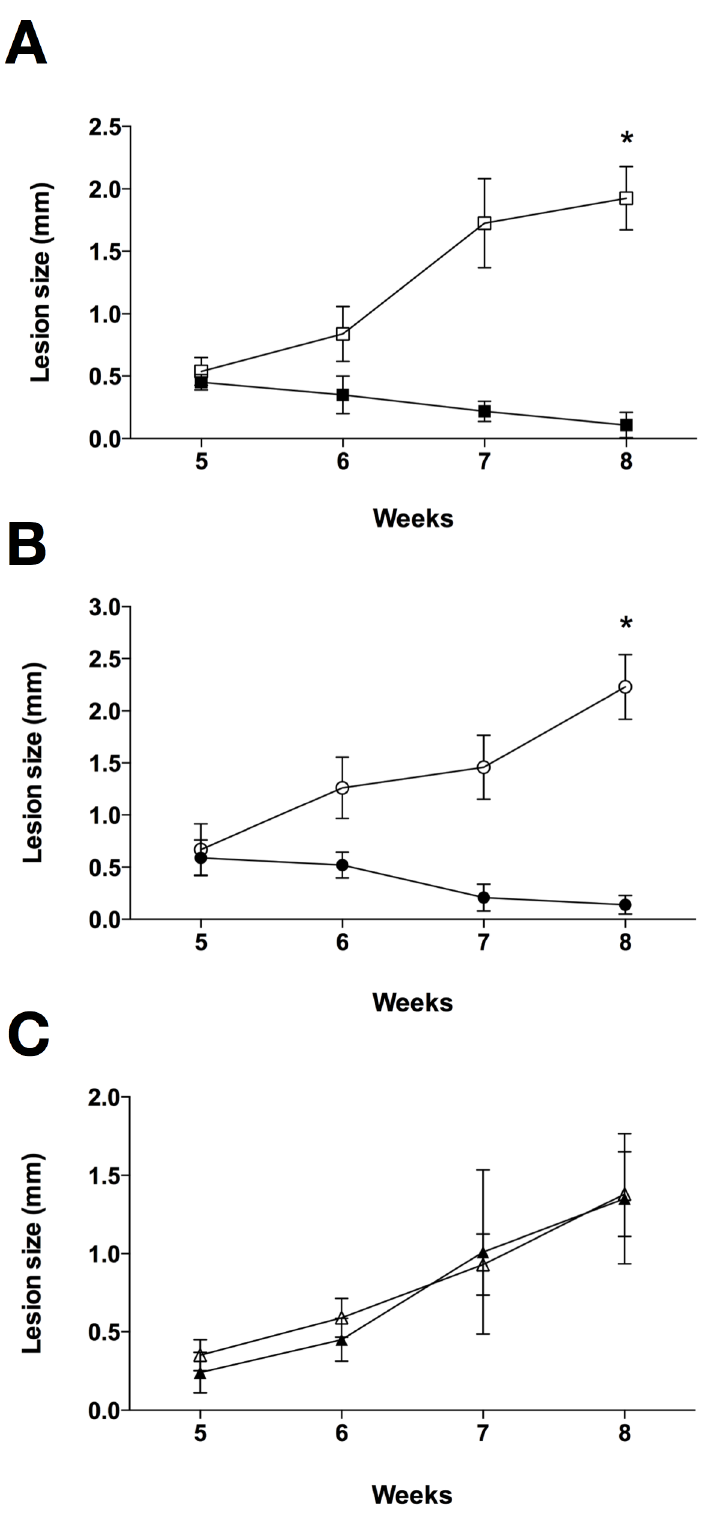
Figure 4. Evaluation of MF efficacy in mice infected with L.amazonensis . Lesion size represents the average difference between infected and contralateral non-infected hind footpads (five mice per group). Animals were treated with 13 mg/kg/day of MF for 15 consecutive days beginning five weeks post-infection. Animals infected with L. amazonensis M2269 strain (A), L. amazonensis 2506 isolate (B) and MF150.3-1 mutant (C) treated or not with MF (filled and open symbols respectively). Statistical analysis was performed with One Way ANOVA, followed by the Tukey post-test. * p , 0.001.